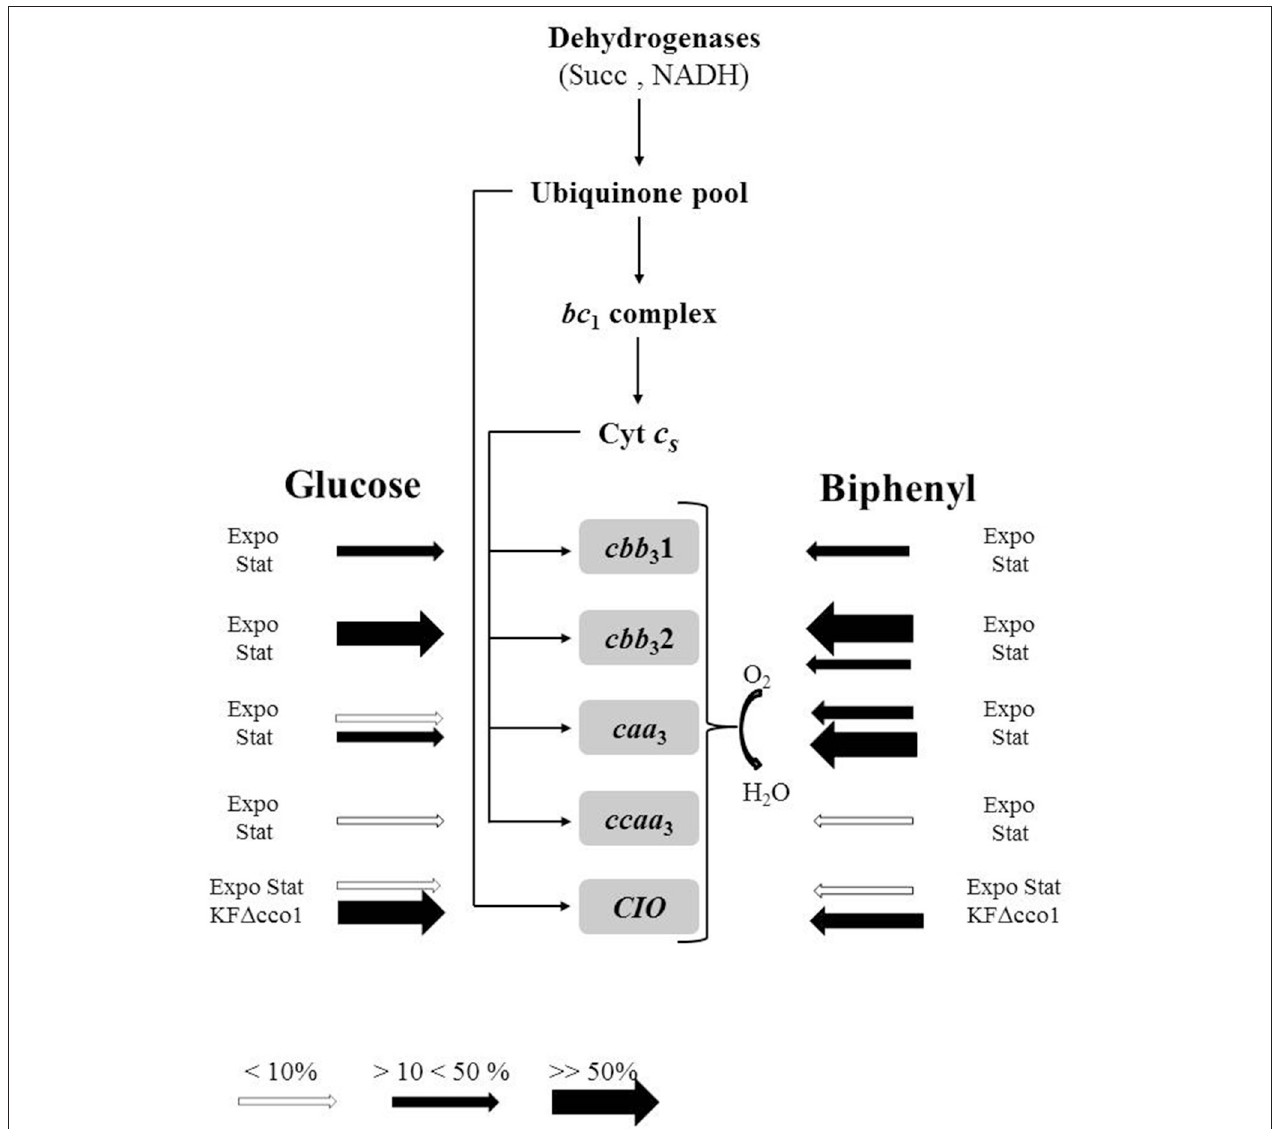
FIGURE 4 | Block scheme illustrating the putative chain of KF707 based on spectroscopic, functional, and genetic analysis (this work and Di Tomaso et al., 2002). Symbols used: Succ, succinate dehydrogenase; NADH, NADH dehydrogenase; Cyt Cs , soluble cytochrome(s) c ; bc 1 complex, cytochrome bc 1 complex III; CIO, cyanide insensitive oxidase ( bd type) (encoded by cioABC ); caa 3 , cytochrome c oxidase (encoded by coxI-II-III cluster); ccaa 3 , cytochrome c oxidase (encoded by coxMNOP ); cbb 3 1, cytochrome c oxidase (encoded by ccoN1O1Q1P1) ; cbb 3 2, cytochrome c oxidase (encoded by ccoN2O2Q2P2 ); KF 1 cco1, Cbb 3 1 minus mutant. The size and color of the arrows symbolize the % level of expression of terminal oxidases under the tested growth conditions, namely: cells grown in